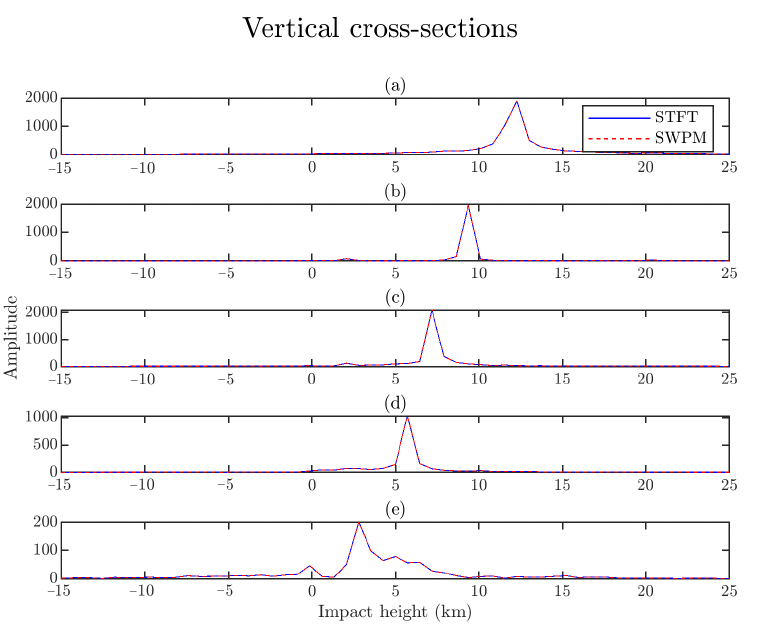
Figure 6. Five vertical cross sections of STFT (solid blue) and SWPM (dashed red) applied to the same